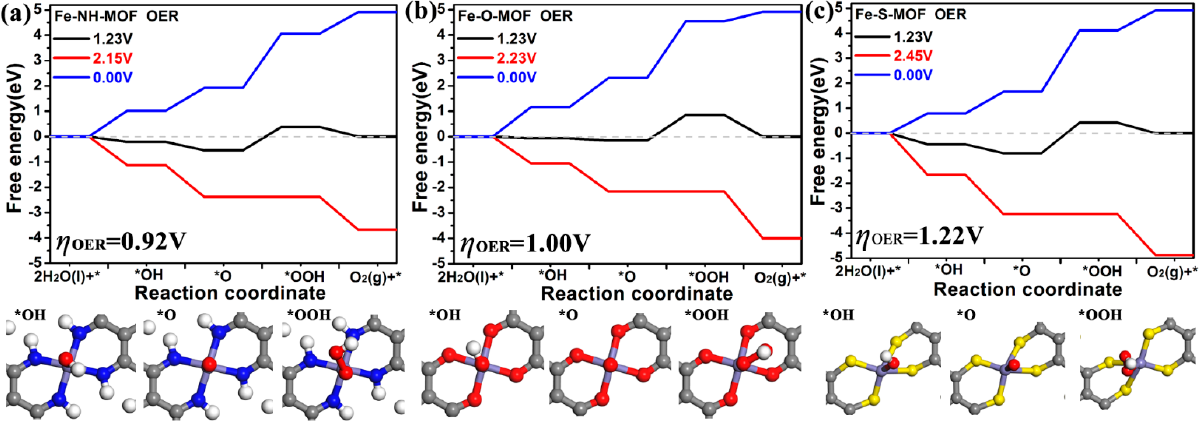
Figure 6. Calculated free energy diagram for OER on ( a ) Fe-NH-MOF, ( b ) Fe-O-MOF, and ( c ) Fe-S- MOF monolayers at a potential U = 0, 1.23, and working potentials relative to the standard hydrogen electrode at pH = 0. Insets are corresponding OER intermediates.